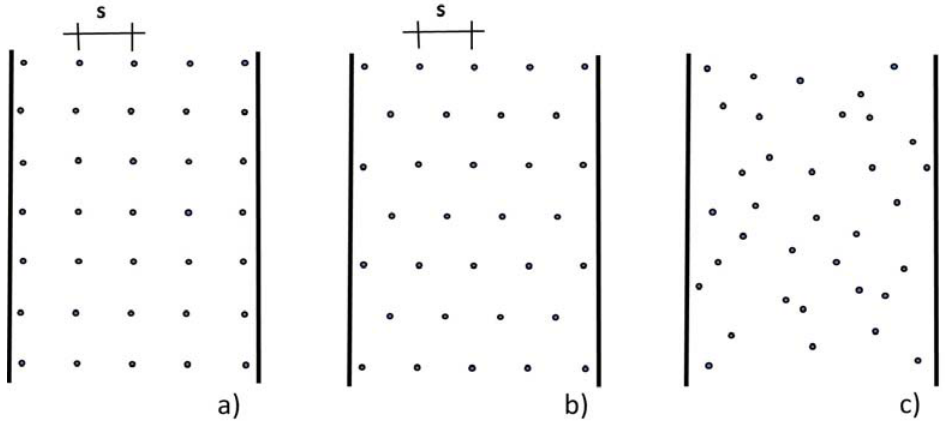
Figure 1. Plan view of ( a ) parallel, ( b ) staggered, and ( c ) random